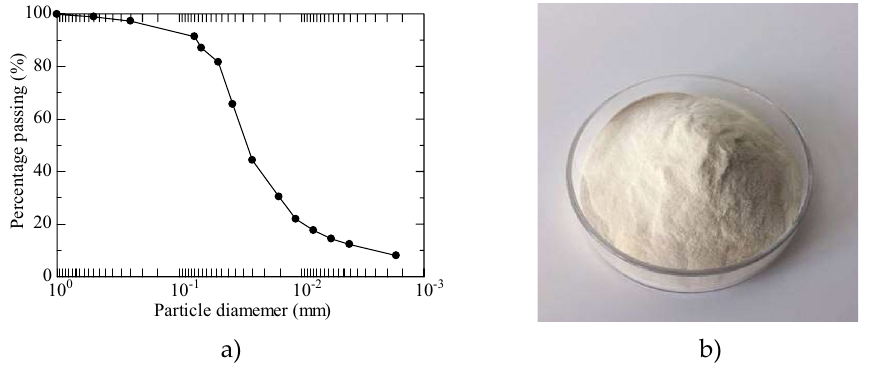
Figure 1. ( a ) Loess particle-size distribution; ( b ) Xanthan gum (XG) powder.